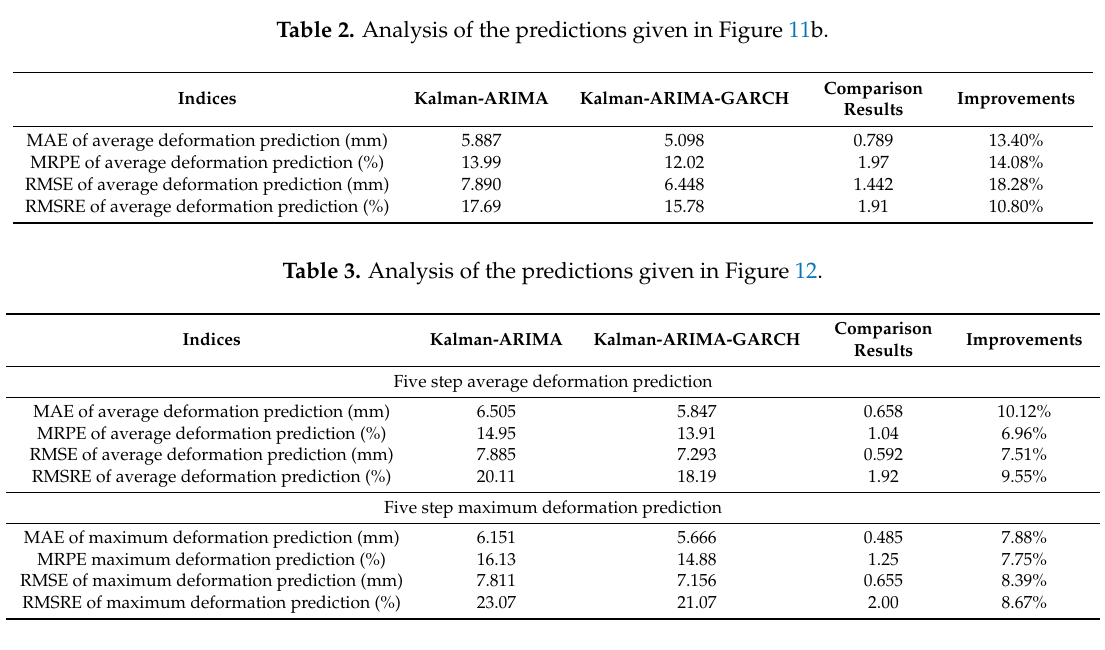
Table 2. Analysis of the predictions given in Figure 11b.